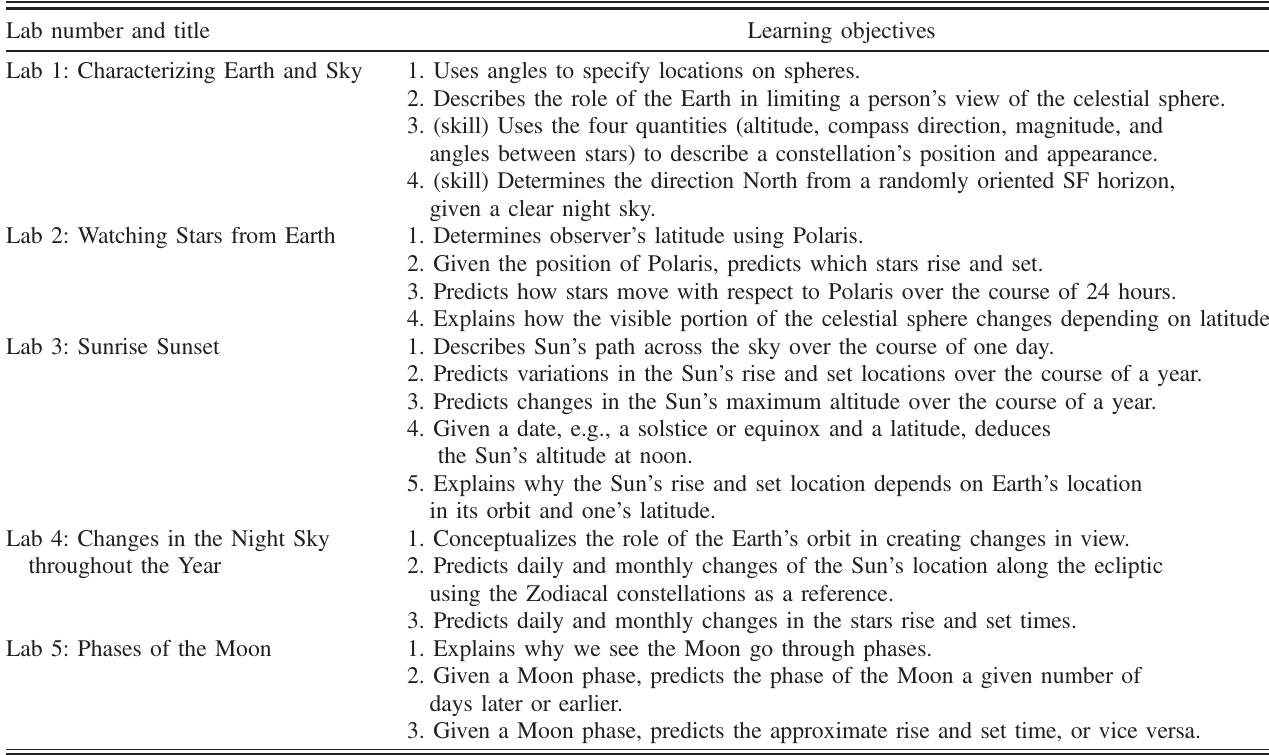
TABLE XI. Learning objectives of each lab in the introductory astronomy laboratory described in this study. Lab number and title